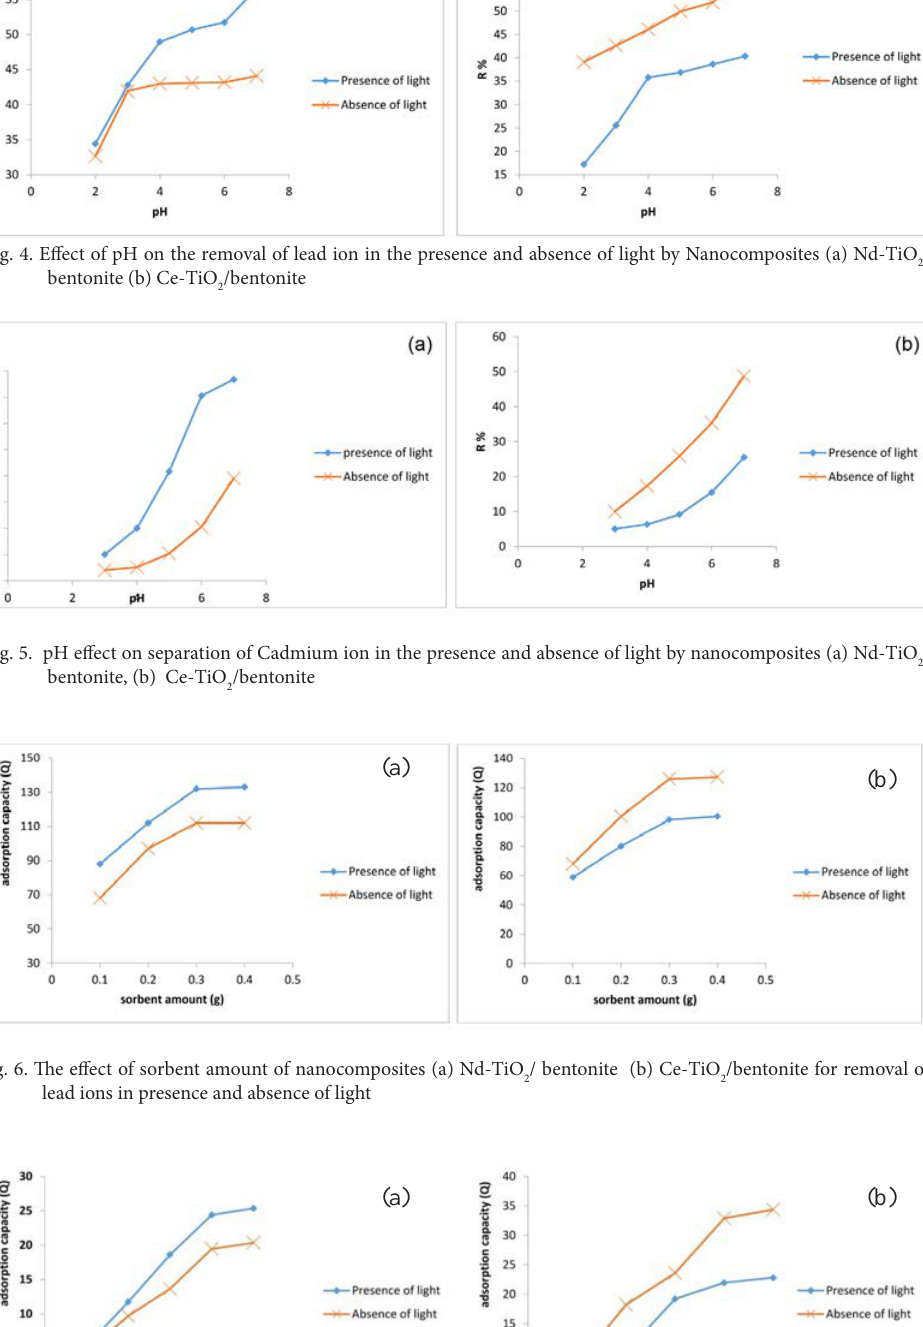
/ bentonite (b) Ce-TiO /bentonite for removal of 2 2